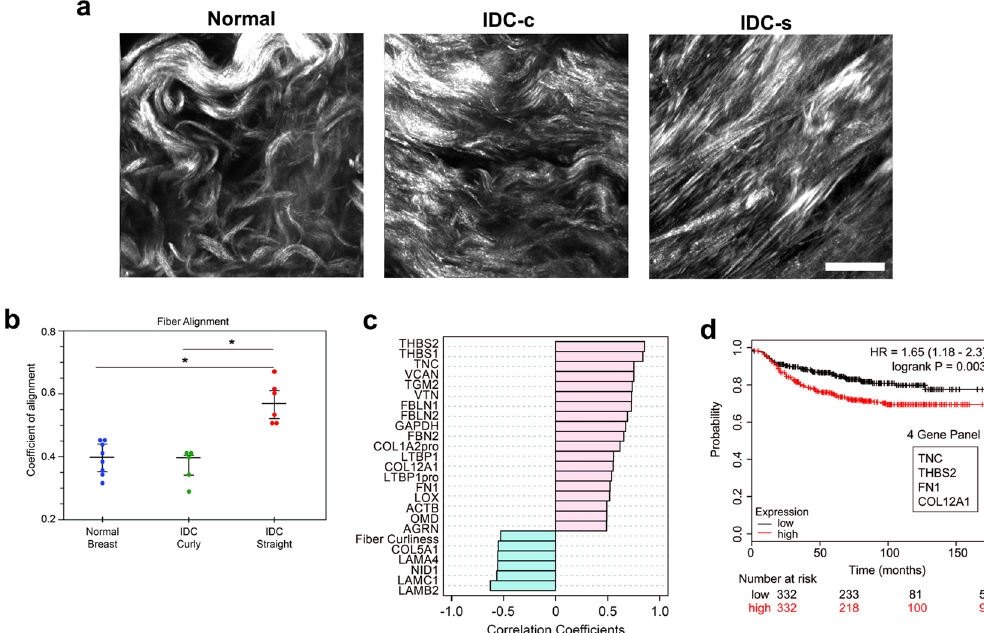
Figure 2. Collagen fiber orientation analysis identifies ECM proteins that correlate with collagen fiber alignment, not simply progression to IDC. ( a ) Representative second-harmonic generation (SHG) images of normal breast and IDC tissues. The normal breast tissues always exhibited curly/wavy, randomly organized collagen (left), whereas the IDC samples showed more variability. Some of the IDC samples contained the randomly organized collagen similar to normal breast (middle), while others possessed straightened/aligned collagen architectures, similar to TACS-3 (right). Images presented here are compressed z-series, ‘max intensity.’ Scale bar = 25 µ m. ( b ) Box plots of ct-FIRE and CurveAlign analysis for all SHG images of patient samples used in this study. Coefficient of alignment ranges from completely random fiber orientation, 0.0, to completely aligned fiber orientation, 1.0. ( c ) Pattern Analysis of log 2 -normalized, quantitative and global proteomics results to fiber alignment (normal breast, n = 8; IDC, n = 11). ( d ) Four increased ECM proteins for IDC/normal breast (collagen XII, COL12A1; fibronectin, FN; tenascin-C, TNC; and thrombospondin-2, THBS-2) formed a heightened correlative signature for poor distant metastasis-free survival in silico , using the K-M plotter database, than any ECM protein individually had